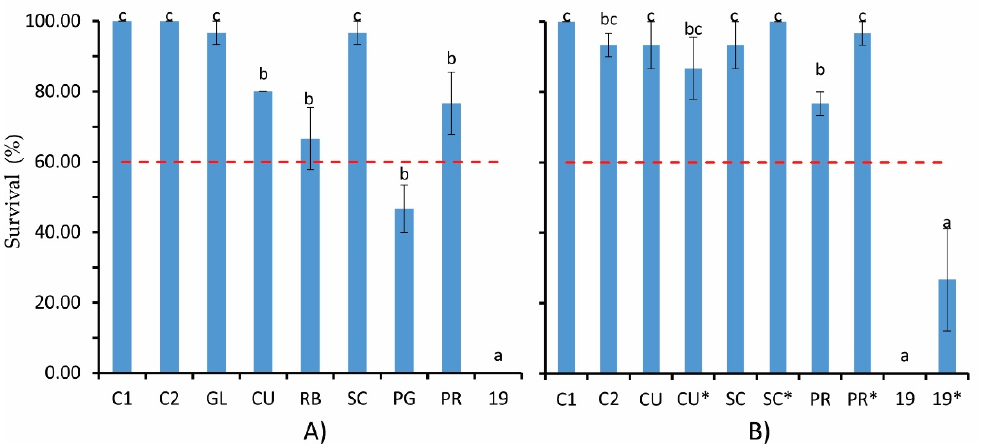
Figure 8. Survival of P. vannamei during the first 48 h, the letters indicate a significant difference p < 0.05 (* indicates that salts were added) ( A ) Survival of P. vannamei PL 20 ( B ) Survival of P. vannamei (30.40 + 2.42 mg).